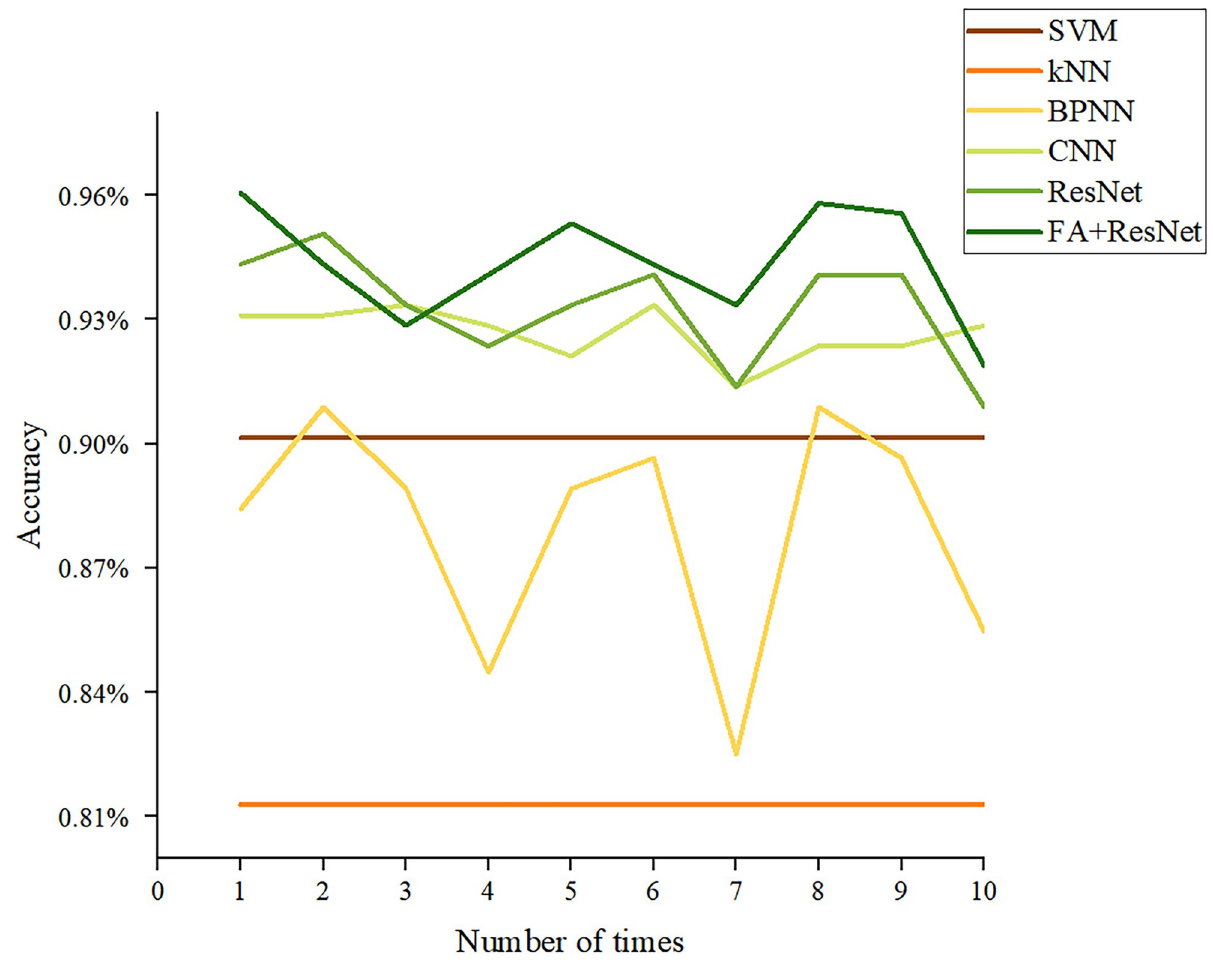
Fig 12. Accuracy comparisons of ten experiments with SVM, KNN, BPNN, CNN, ResNet, FA+ResNet models.